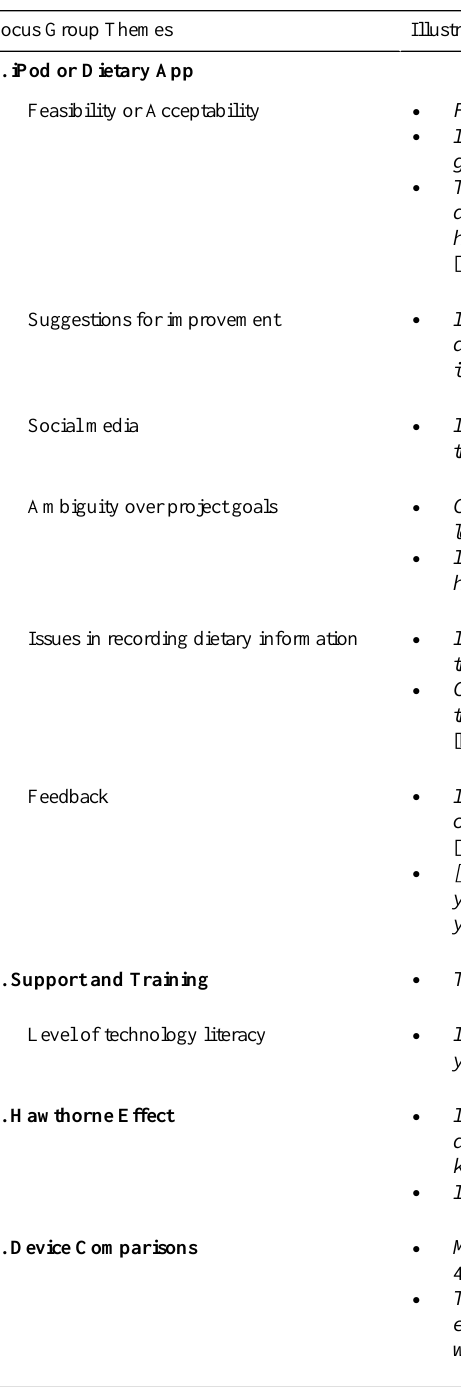
Table 4. Focus group themes, subthemes, and illustrative quotes; CV Health and Needs Assessment Qualitative Study.